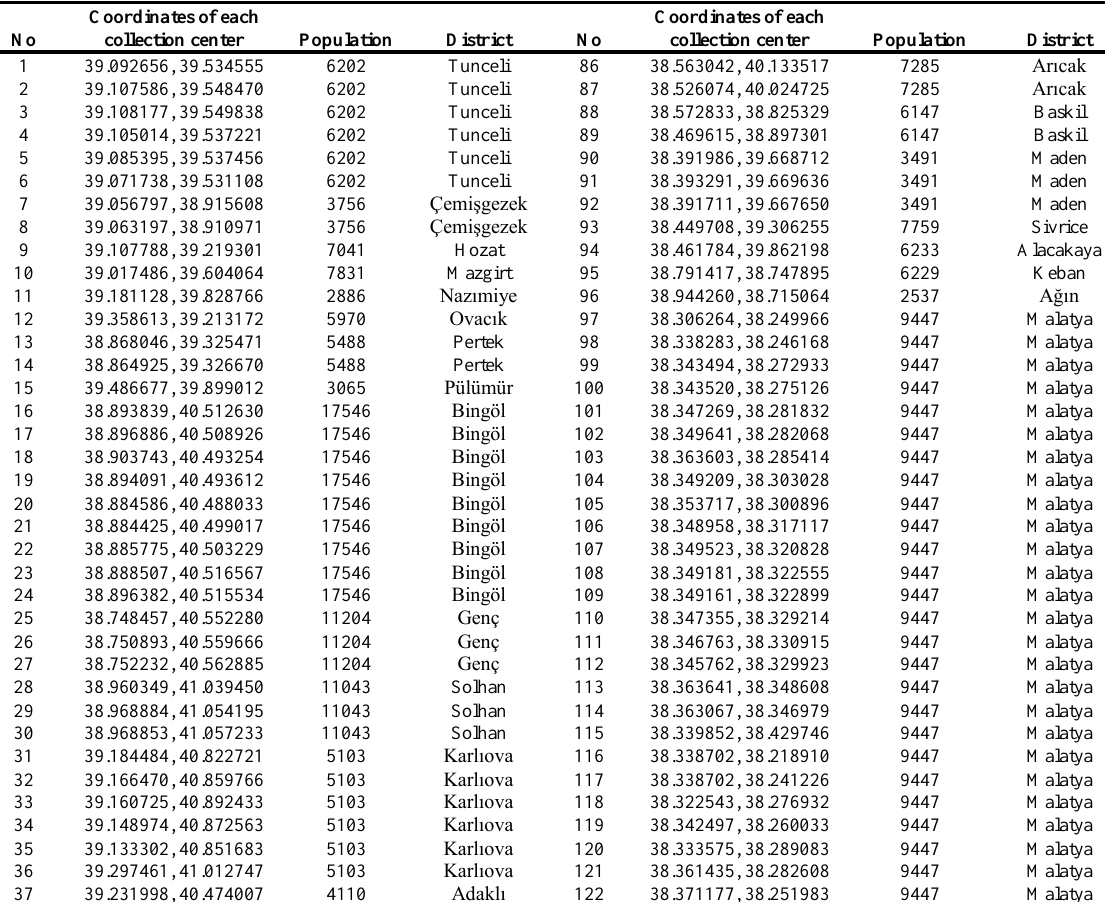
Table A1. Details of each collection center (health